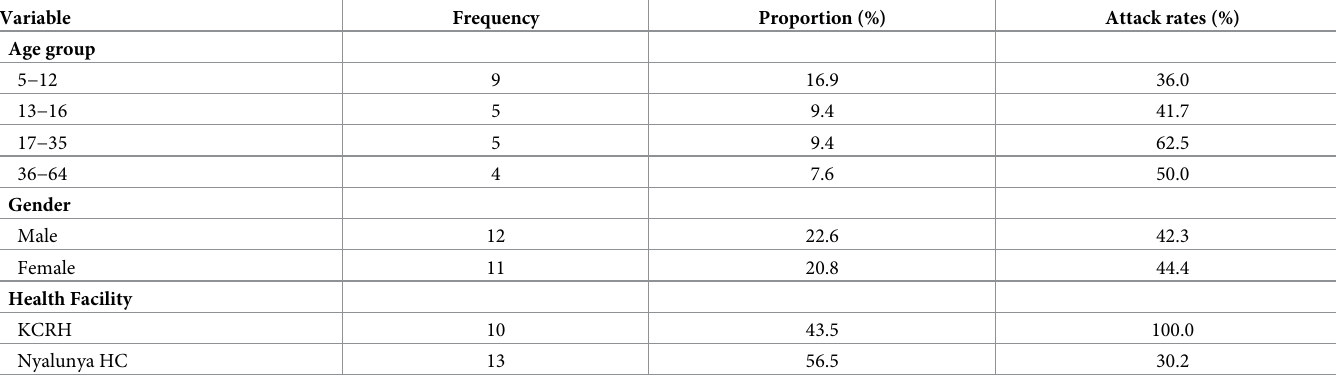
Table 1. Frequency distribution, facility, age, gender-specific attack rates for Anthrax Kisumu East Sub County 2019. Variable